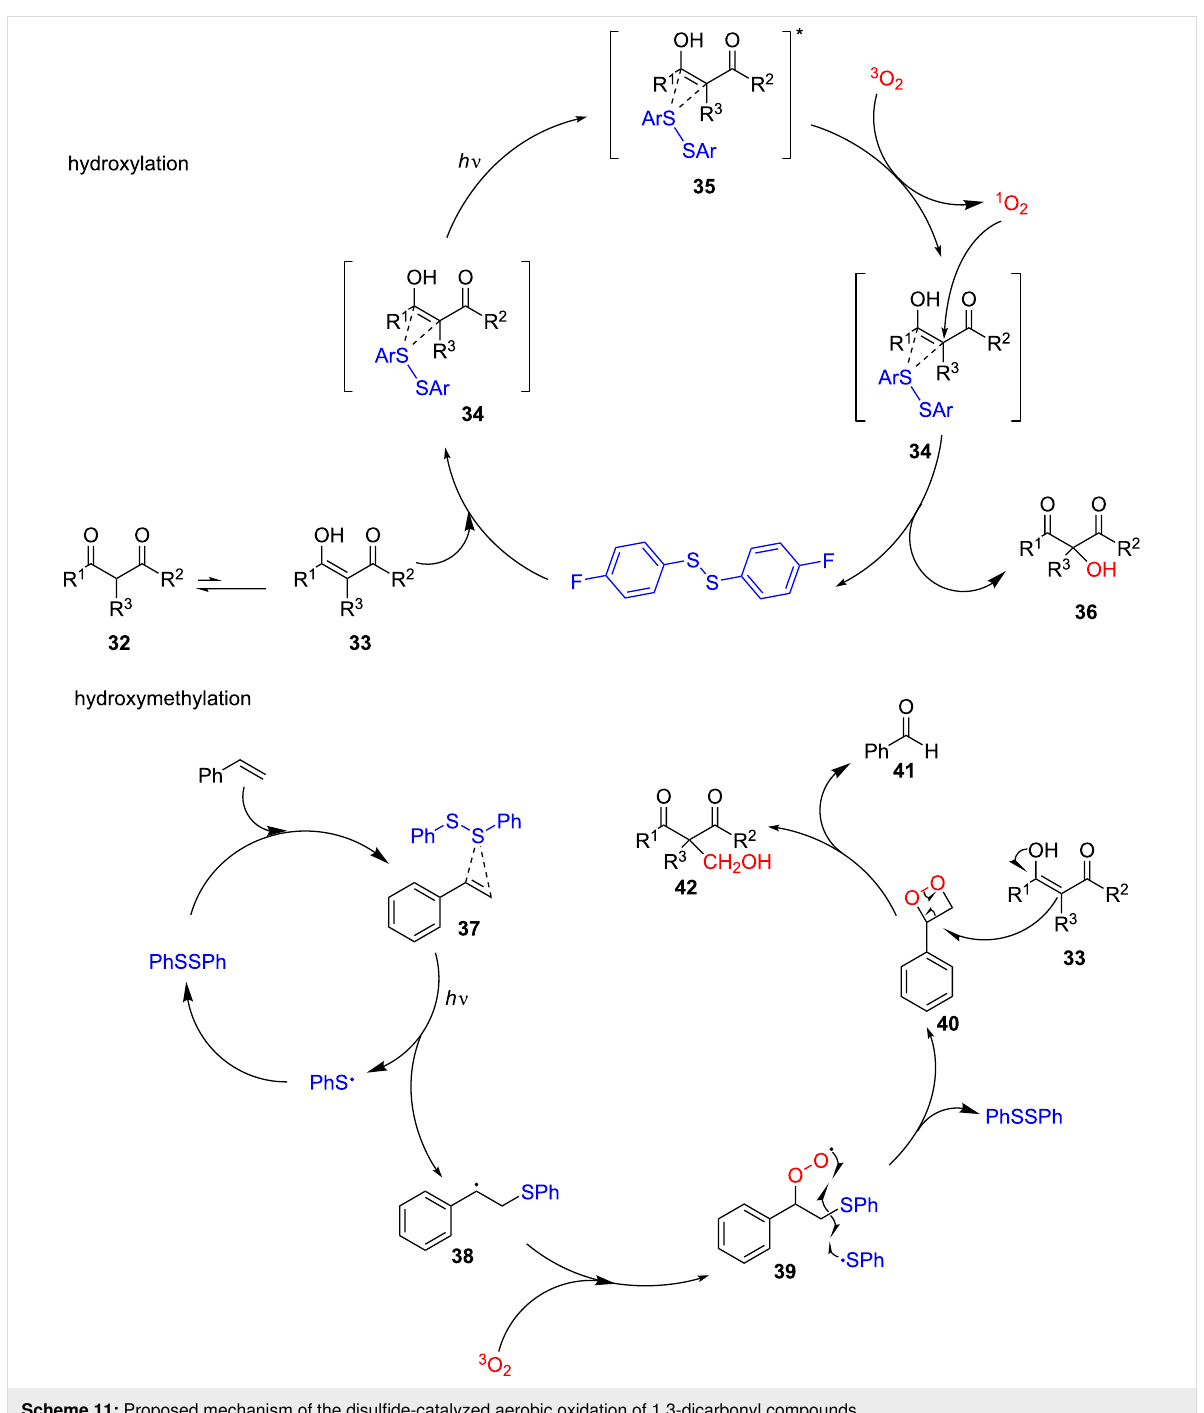
Scheme 11: Proposed mechanism of the disul fi de-catalyzed aerobic oxidation of 1,3-dicarbonyl compounds.